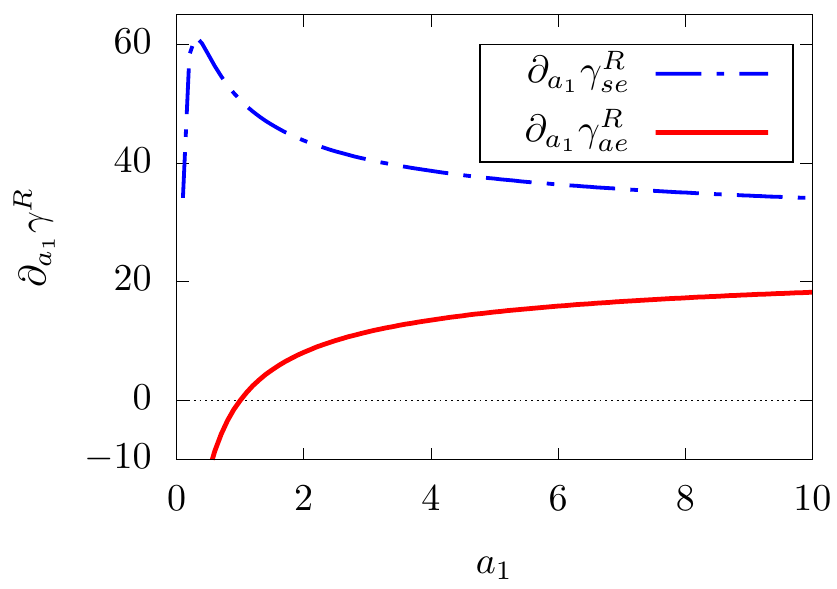
Figure 14 . The quantity ∂ a γ R is plotted with respect to varying a 1 for accelerated atoms in se 1 thermal background considering Rindler modes, depicted by dash-dotted blue line. The quantity ∂ a γ R is plotted with respect to varying a 1 for accelerated atoms in thermal background considering ae 1 Rindler modes, depicted by solid red